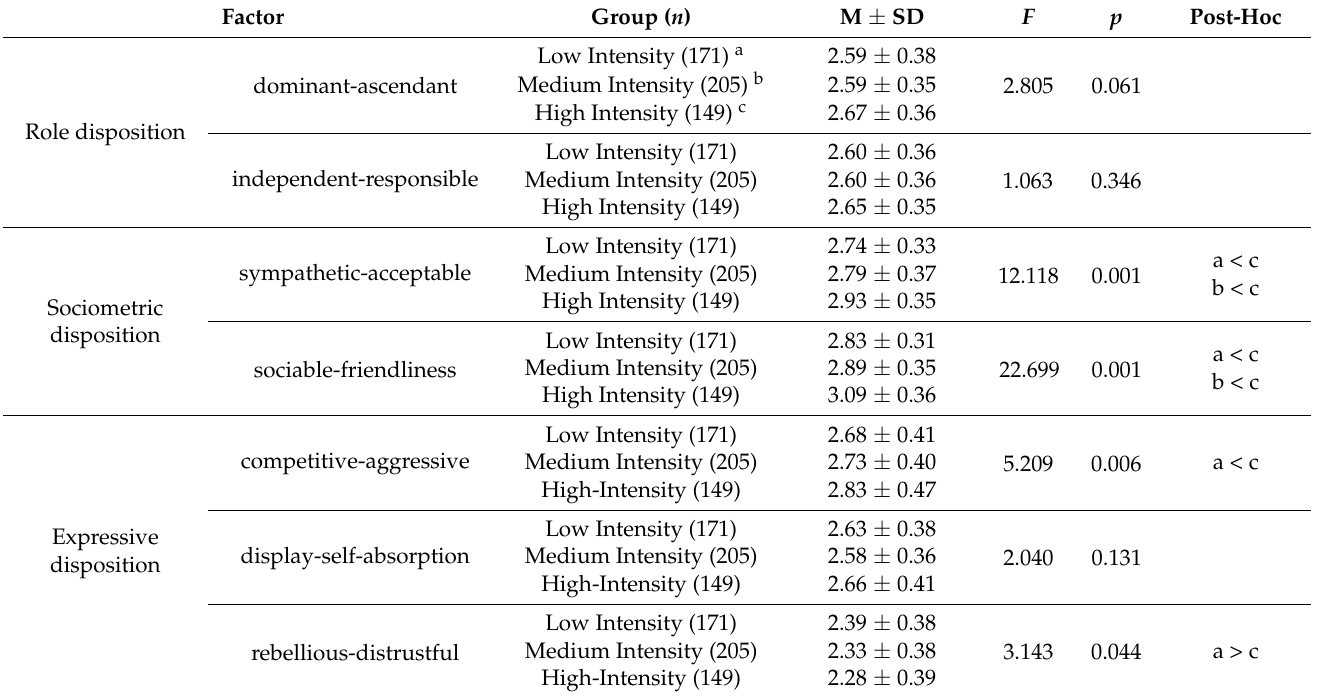
Table 7. Differences in personal relationships depending on the amount of physical activity ( n =